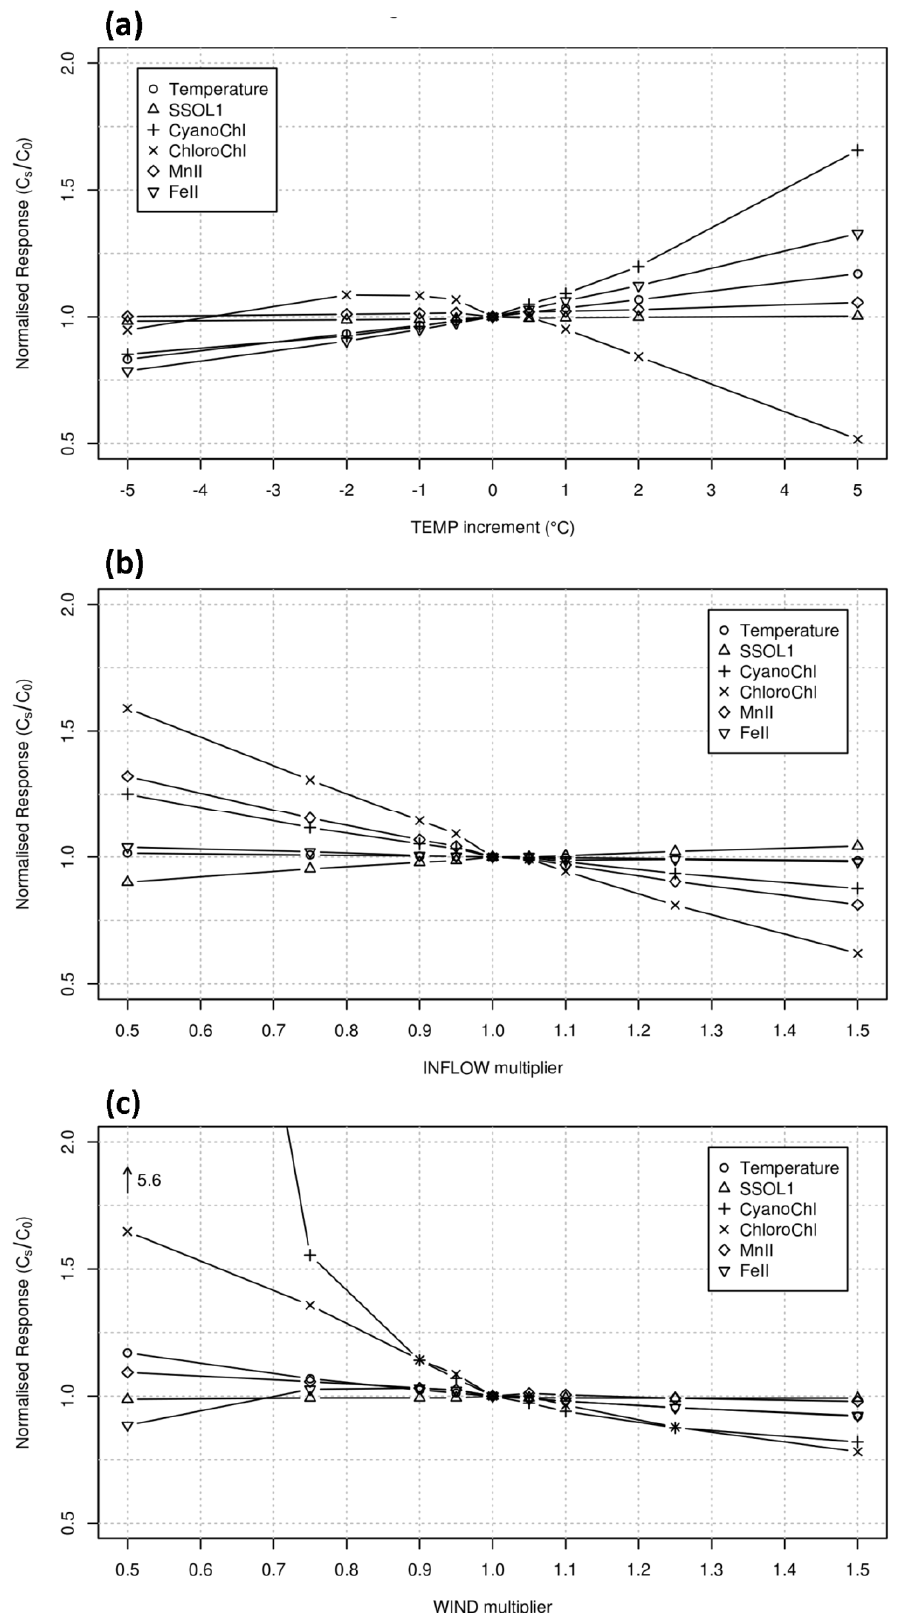
Figure 2. Change in mean modeled water quality values over the summer period in the different sensitivity analysis scenarios where temperature ( a ); rate of inflow and outflow ( b ) or wind speed ( c ) were incrementally